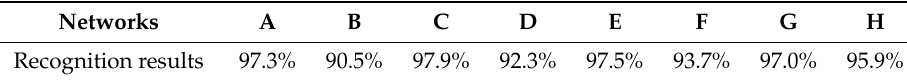
Table 10. Recognition results of di ff erent